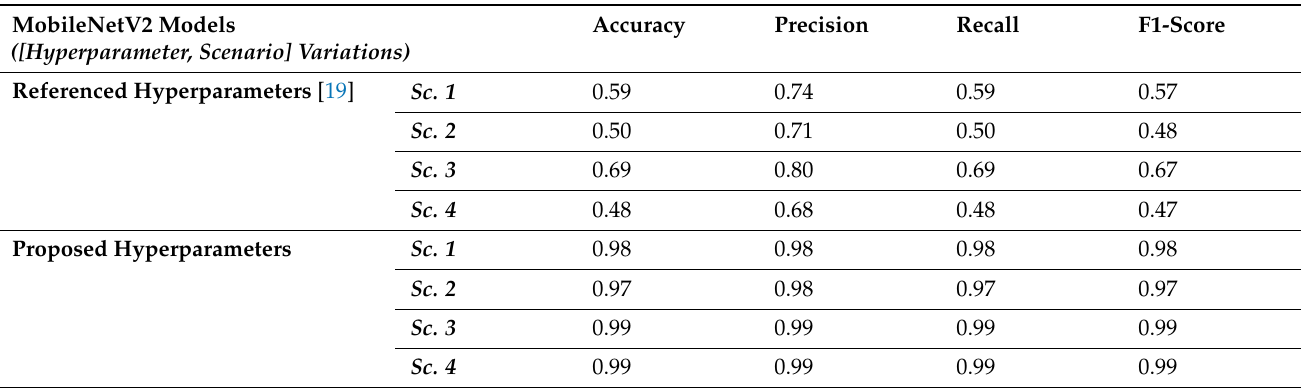
Table 2. Evaluation scores for developed MobileNetV2 models.